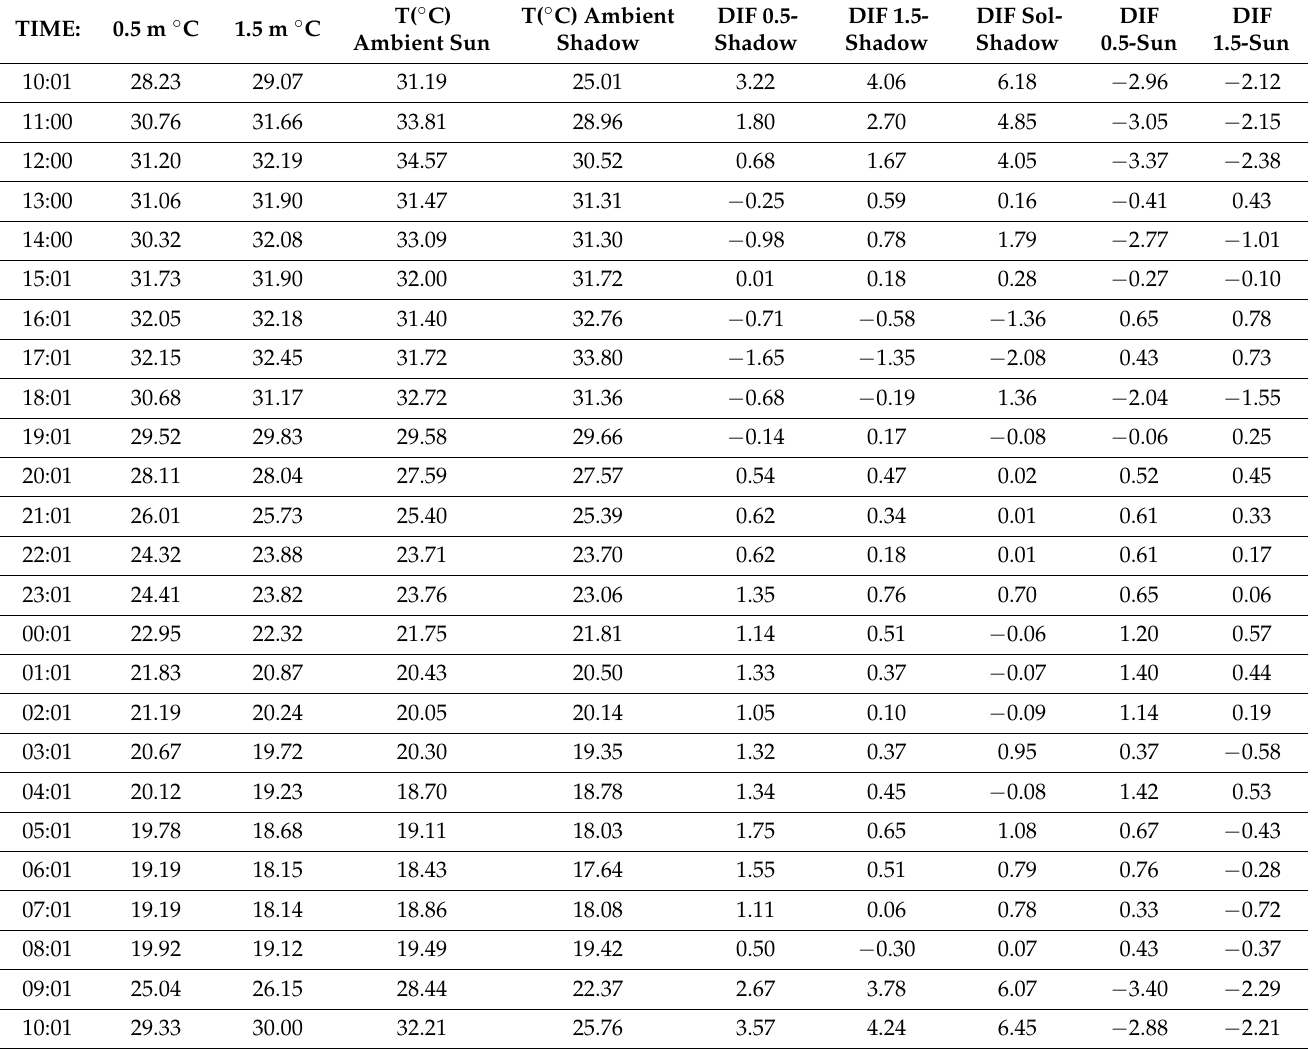
Table 3. Obtained temperatures. Date from 21–22 May